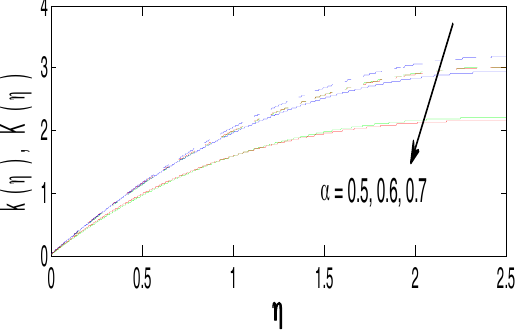
Figure 5. Impact of l on velocity profile ' f and ' F of fluid with dusty particles.